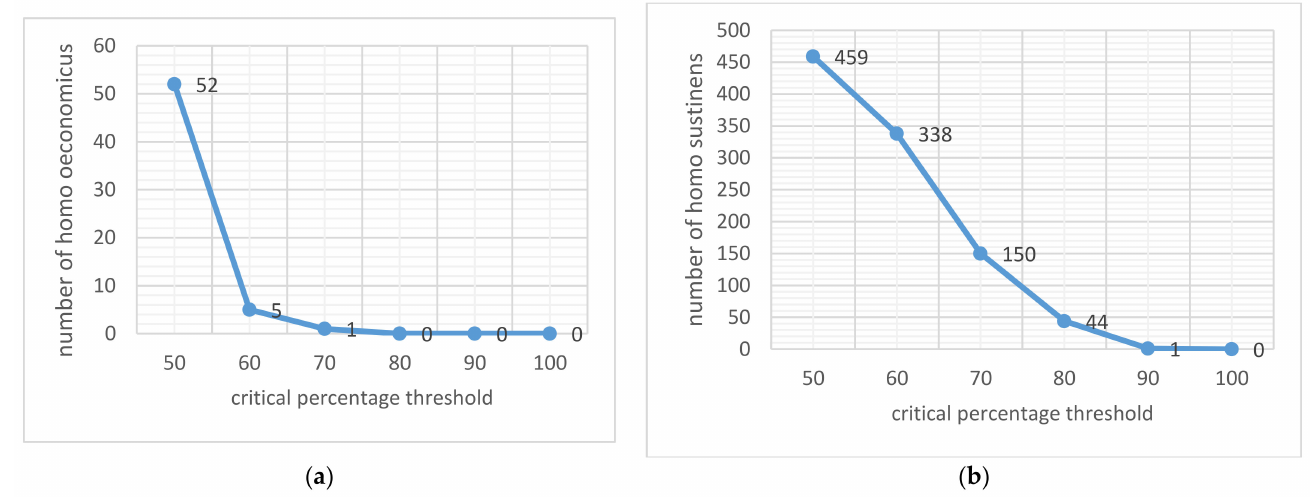
Figure 3. The number of households identified as ( a ) homo oeconomicus or ( b ) homo